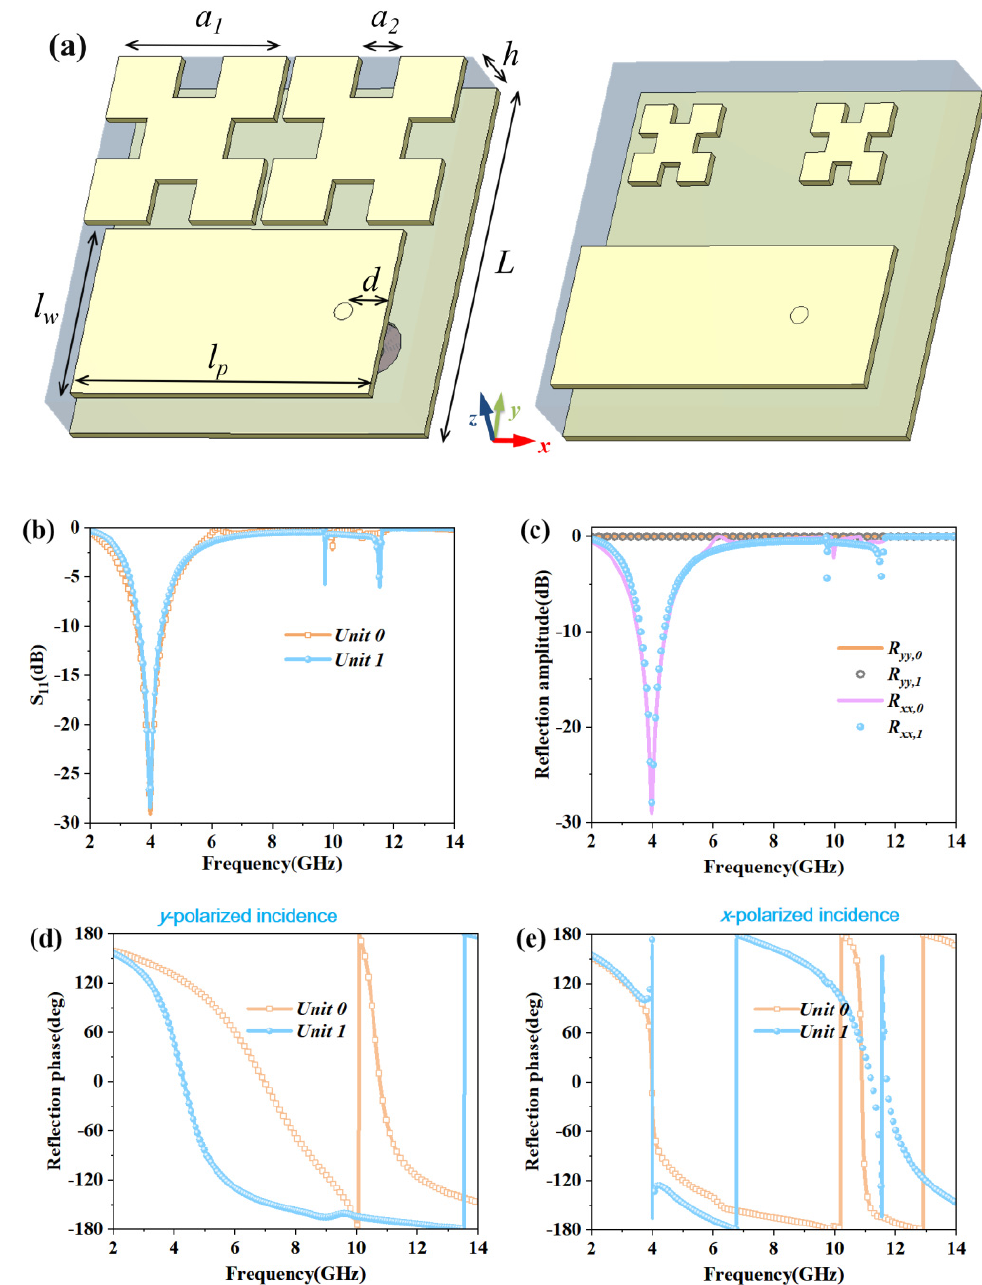
Figure 2. Geometry and characteristics of unit cells “0” and “1”. ( a ) The unit cells “0” and “1”; ( b ) Simulated amplitude results of reflection for unit cells “0” and “1” with radiation mode; ( c ) Reflection amplitude of unit cells “0” and “1” in plane incident waves; ( d , e ) Reflection phase of unit cells “0” and “1” for y - or x -polarized plane incident waves.